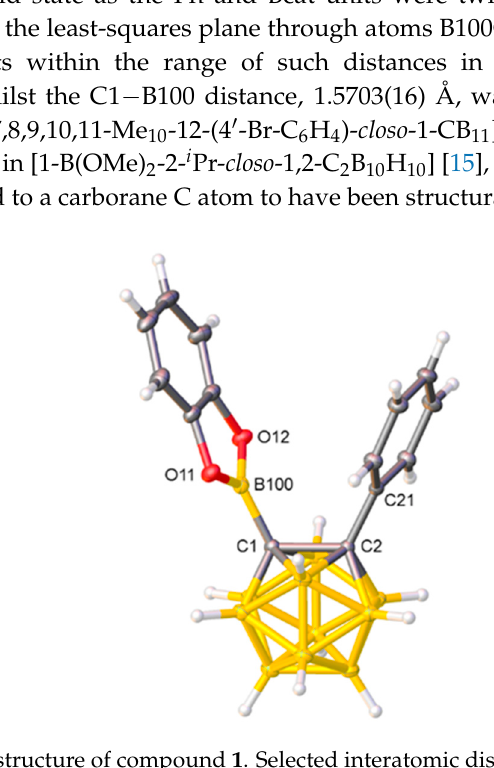
Figure 1. Molecular structure of compound 1 . Selected interatomic distances (Å): C1 − C2 1.6840(15), C1 − B100 1.5703(16), B100 − O11 1.3744(14), B100 − O12 1.3739(15), and C2 − C21